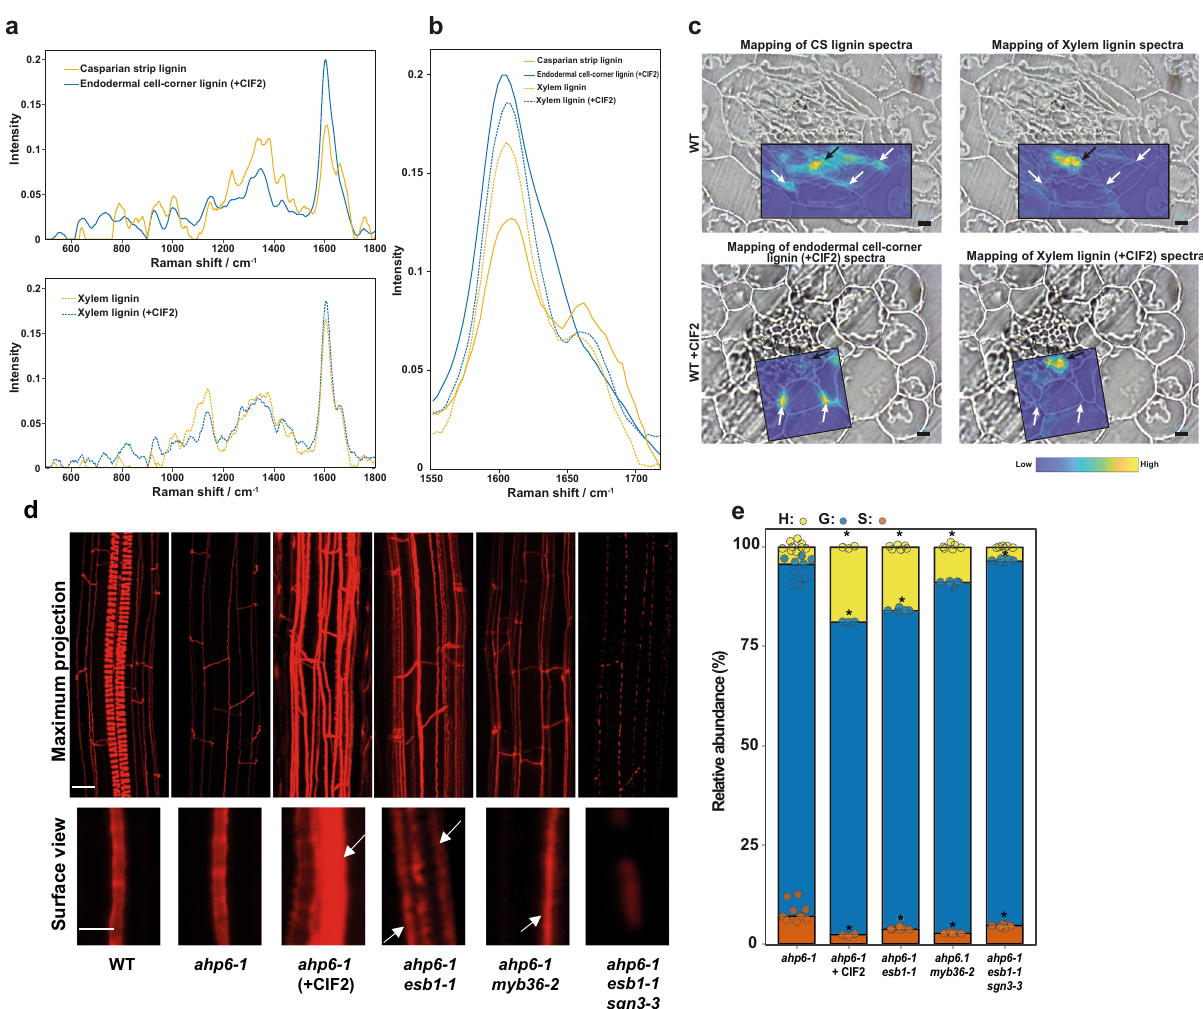
Fig. 2 Activation of the Schengen-pathway triggers the deposition of a distinct “ stress ” lignin in the endodermis. a Raman spectra of lignin of the different regions of interest presented in Supplementary Fig. 1 and determined using a Multivariate Curve Resolution (MCR) analysis. The MCR analysis was performed on small Raman maps from independent plants containing CS lignin of WT ( n = 8), cell-corner lignin of WT treated with CIF2 ( + CIF2; n = 5) and for xylem lignin of WT ( n = 2) and xylem lignin of WT treated with CIF2 ( n = 2). b Close view of Raman spectra presented in ( a ) in the lignin aromatic region between 1550 and 1700 cm − 1 . c Large Raman maps in root cross-sections of WT and WT treated with CIF2 ( + CIF2). The intensity of the different lignin spectra presented in ( a ) was mapped onto large Raman maps containing xylem and endodermal lignin. Scale bar = 5 µ m. d Lignin staining with basic fuchsin at a distance of 3 mm from the root tip in WT, ahp6-1 , ahp6-1 esb1-1 , ahp6-1 esb1-1 sgn3-3 , ahp6-1 myb36-2 and ahp6-1 treated with CIF2. The plants were grown for 6 days in presence of 10 nM 6-Benzylaminopurine (BA). Upper panel shows a maximum projection of the root (scale bar = 10 µ m). Spiral structures in the centre only observed in the WT root are protoxylem. Lower panel shows surface view of endodermal cells. The experiment was repeated two times independently with similar results (scale bar = 5 µ m). White arrows indicate ectopic ligni fi cation. e Relative abundance of the lignin monomers released by thioacidolysis ( p -hydroxyphenyl (H), guaiacyl (G), and syringyl (S) units) in root tips of ahp6-1 ( n = 9), ahp6-1 treated with CIF2 ( + CIF2; n = 3), ahp6-1 esb1-1 ( n = 6), ahp6-1 myb36-2 ( n = 6) and ahp6-1 esb1-1 sgn3-3 ( n = 6). Asterisks represent signi fi cant differences from the ahp6-1 control for each individual monomer using a two-sided Mann – Whitney U test ( p value <